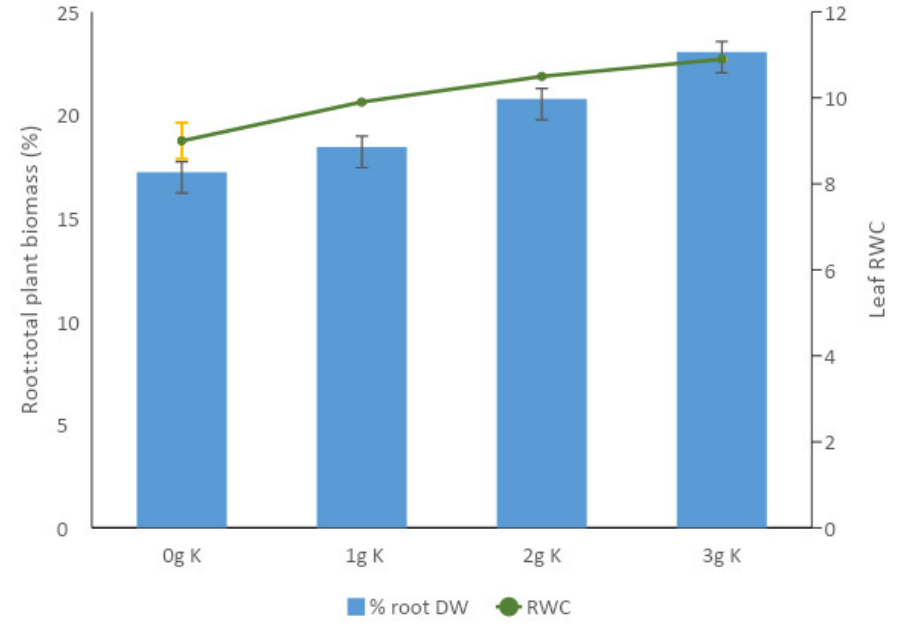
Figure 7. Effect of potassium on the proportion of dry matter partitioned to roots and leaf relative water content (RWC) of cocoa seedlings evaluated under water stress conditions in a gauzehouse facility. RWC was determined at 35 days after water stress, root dry weight at 55 days after stress. Values represent data from experiment 1.